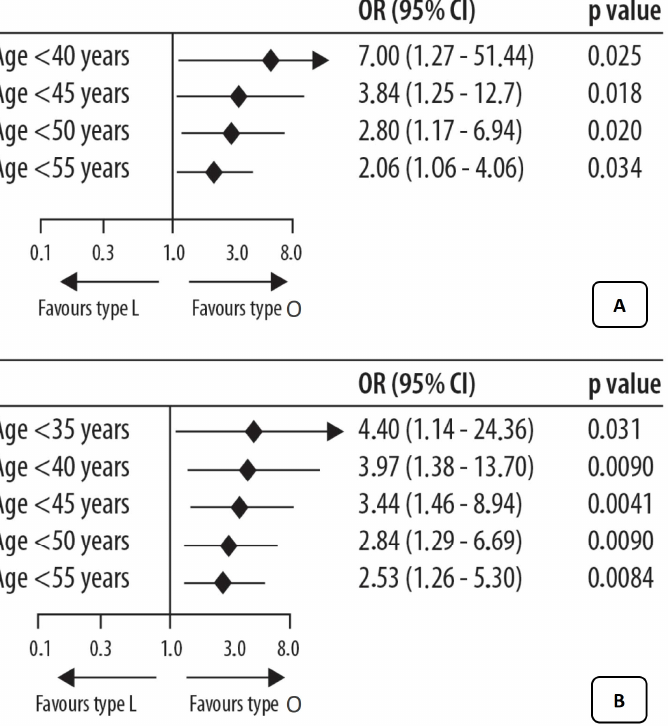
Figure 2. Prognostication of CST for age cluster in ovarian oncological pathology set: ( A ) with ovarian oncological pathology status as the predictor, ( B ) in the BRCA set (mutation status) as the predictor [16]. As discussed in the text, these data suggested a greater influence in relation to the age of the patients, with a progressively greater relationship in younger ages.